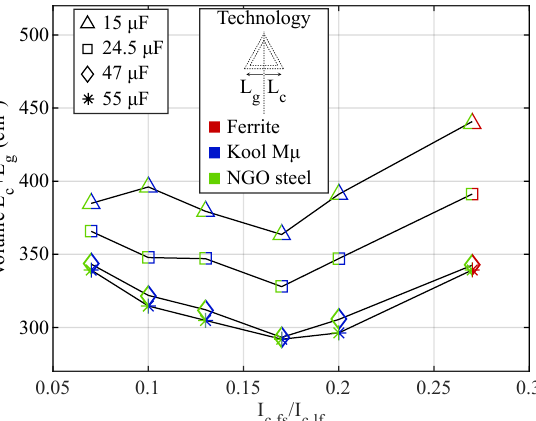
Figure 5. Technologies that result in smallest combined volume of L c + L g , as a function of I c , f for different C f .